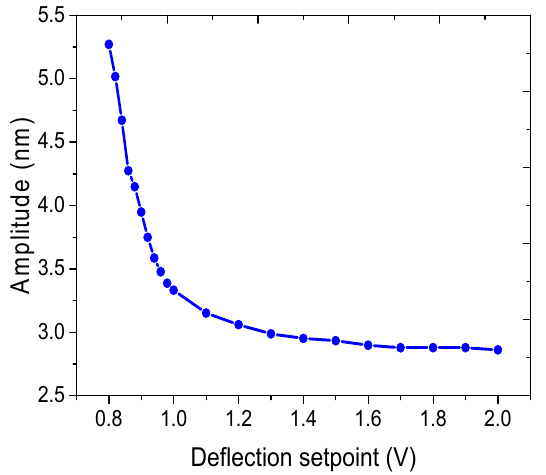
Figure 9 . Amplitude response measured at different deflection setpoints in contact mode. Figure 9. Amplitude response measured at different deflection setpoints in contact